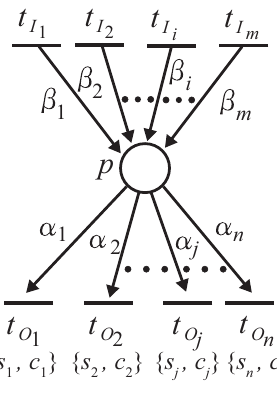
Figure 5. An example illustrating a conflict